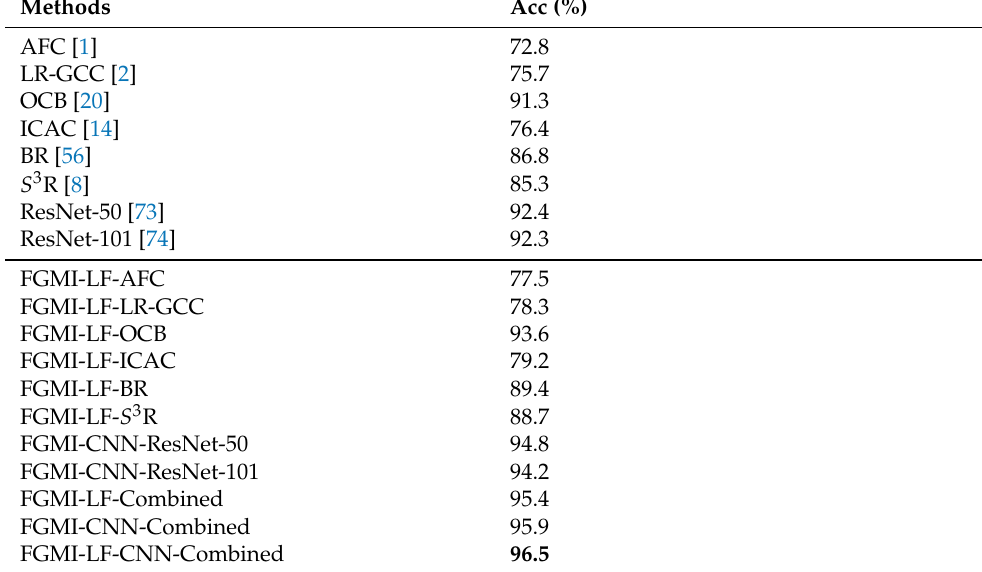
Table 2. Fine-grained classification performances of FGMI-LF and other baseline methods on the Flower-102 dataset. FGMI-LF-AFC, FGMI-LF-LR-GCC, FGMI-LF-OCB, FGMI-LF-ICAC, FGMI-LF- BR, and FGMI-LF- S 3 R represent the proposed method combined with prelearned AFC, LR-GCC, OCB, ICAC, BR, and S 3 R models, respectively. FGMI-CNN-ResNet-50 and FGMI-CNN-ResNet-101 represent the proposed method combined with prelearned ResNet-50 and ResNet-101, respectively. FGMI-LF-Combined represents the proposed method combined with AFC, LR-GCC, OCB, ICAC, BR, and S 3 R jointly. FGMI-CNN-Combined represents the proposed method combined with ResNet-50 and ResNet-101 jointly. FGMI-LF-CNN-Combined represents the proposed method combined with FGMI-LF-Combined and